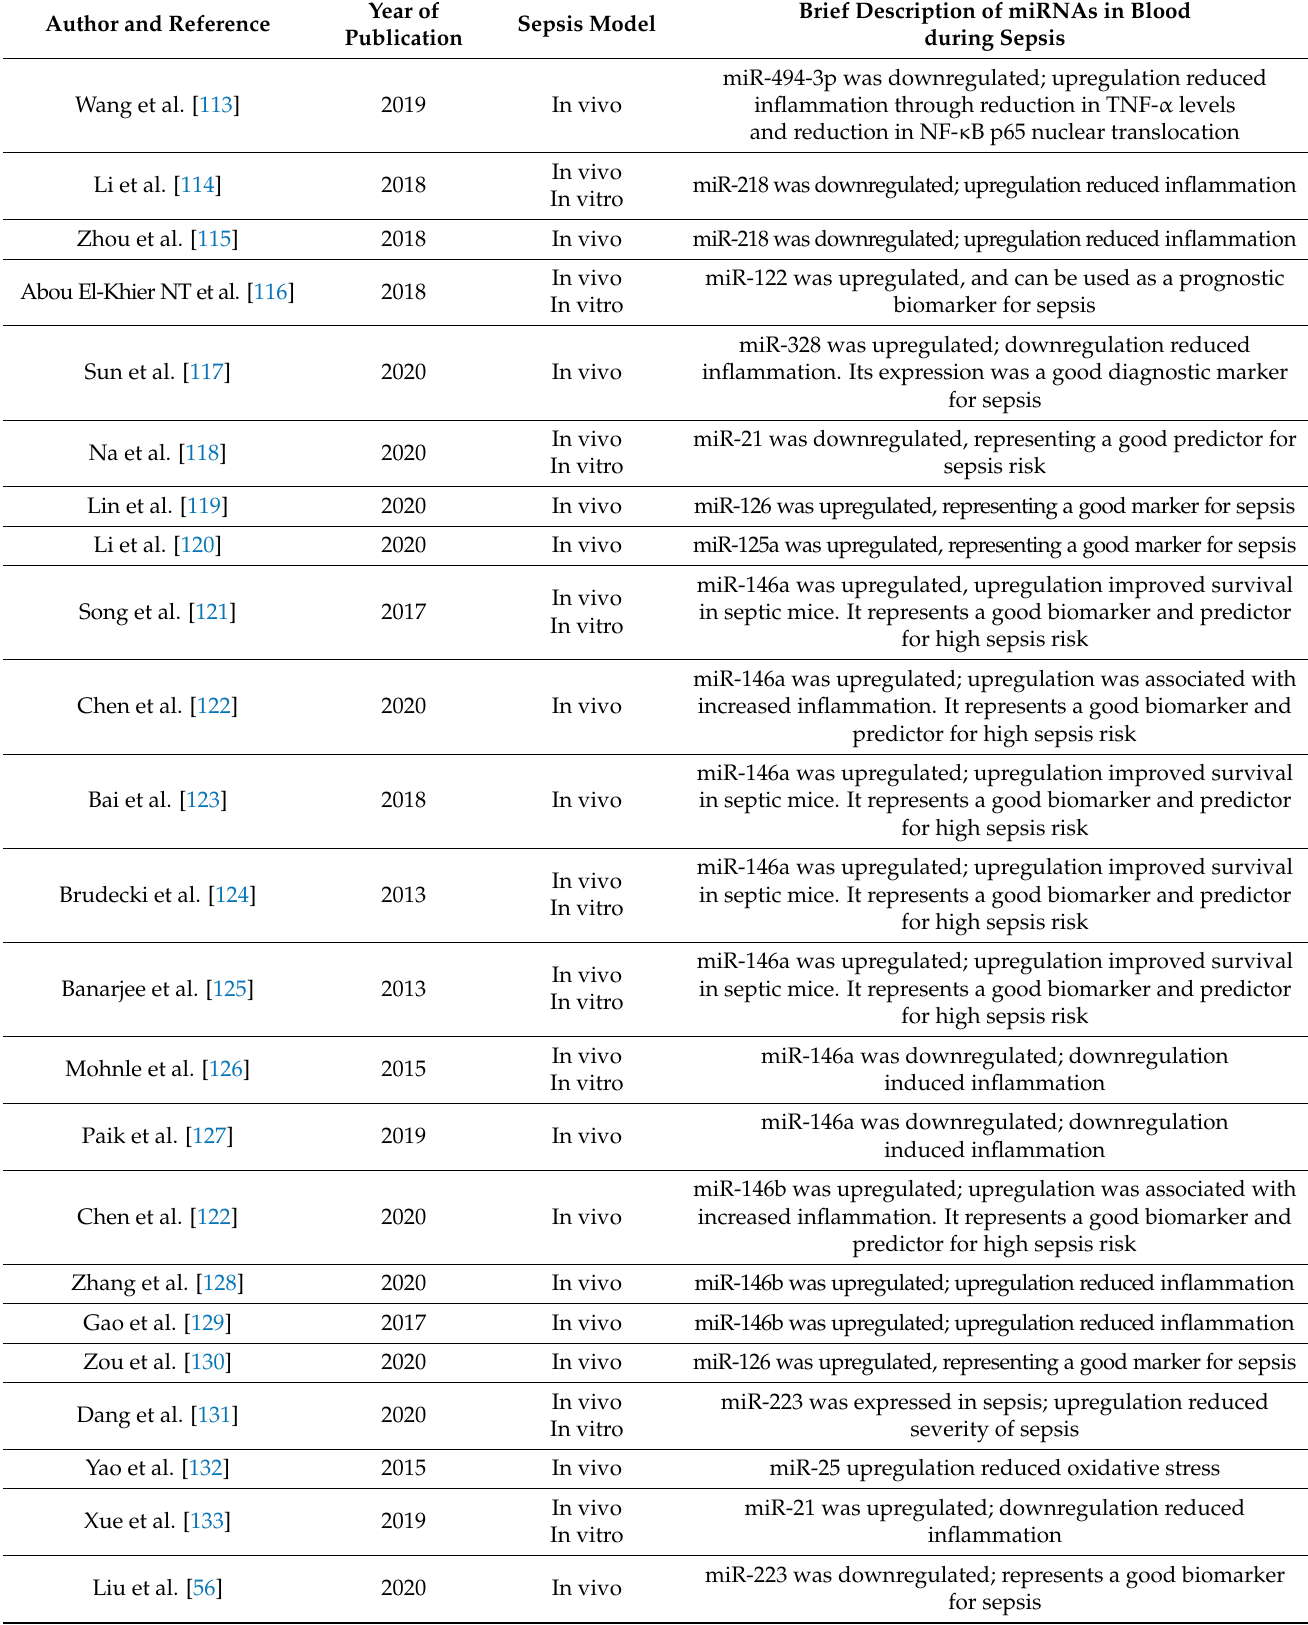
Table 3. miRNA expression in blood during